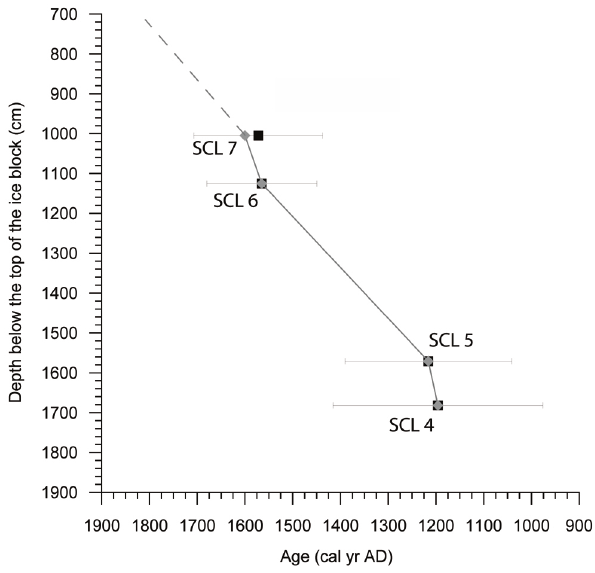
Fig. 4. Depth-age model of the exposed ice wall in Little Reserva- tion, Sc˘aris¸oara Ice Cave.